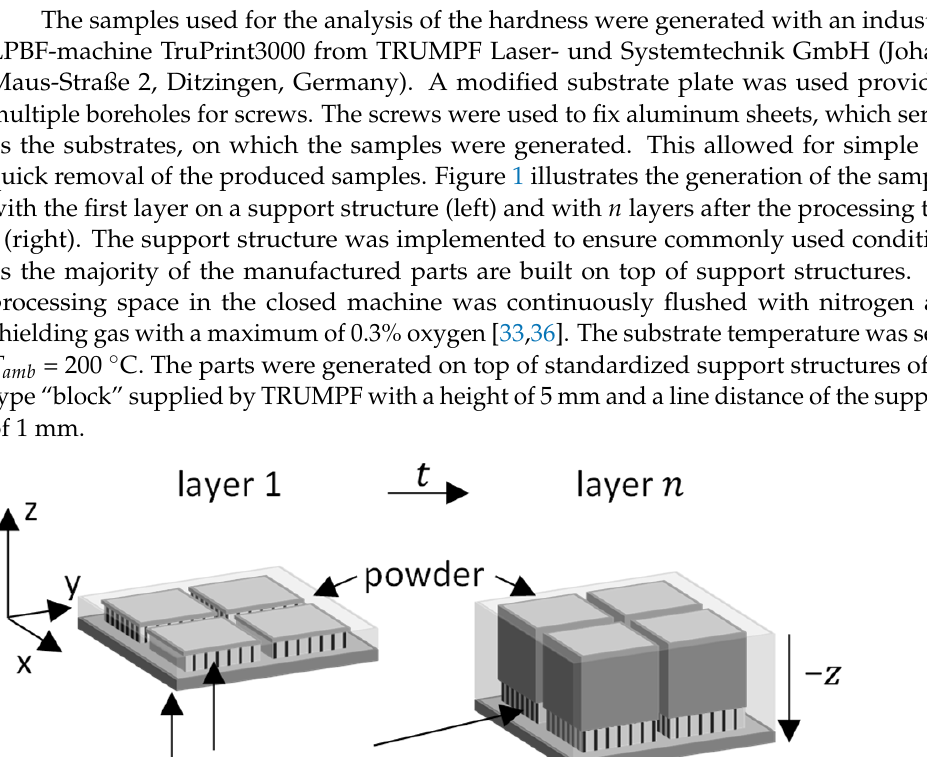
Figure 2. A single layer during the generation of the cube. The beam path vectors inside of the pat- terns are either perpendicular or parallel to the contour.